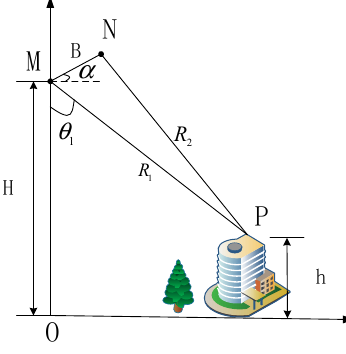
Figure 1. The schematic diagram of InSAR.